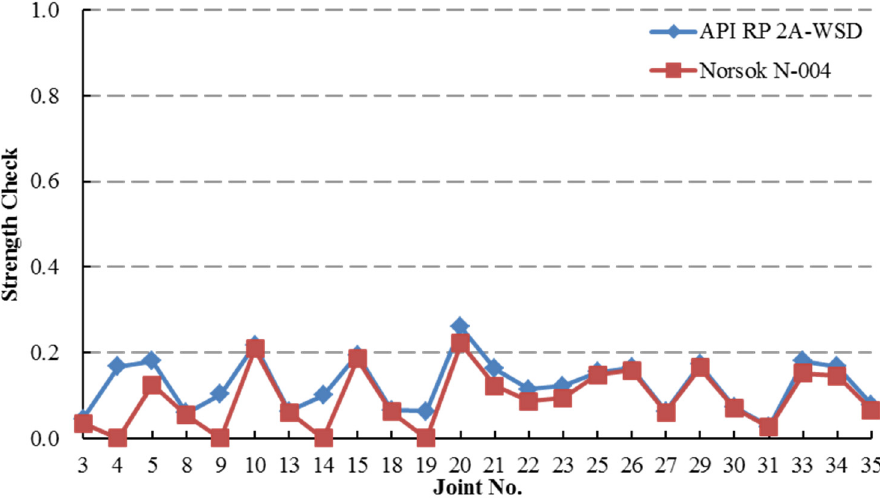
Figure 29. Joint Strength Check (Case 5).